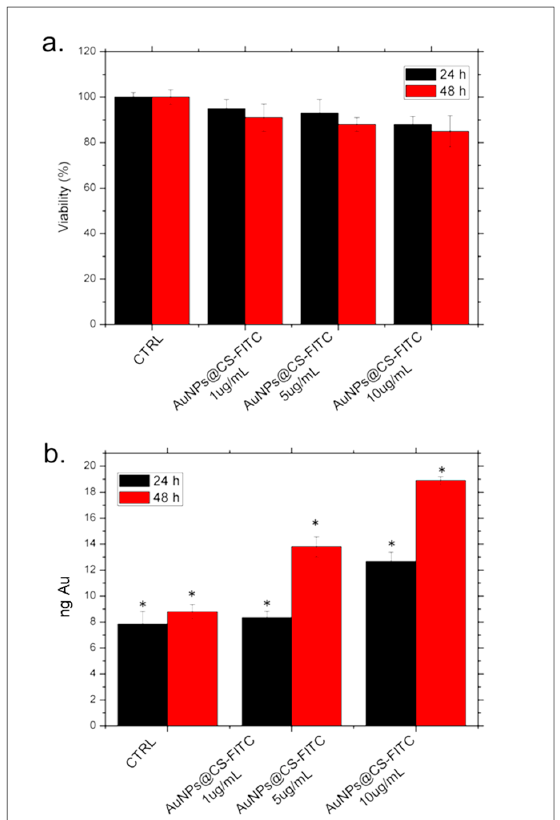
Figure 5. Emission spectra ( λ ex = 488 nm) of FITC and AuNPs@CS-FITC.